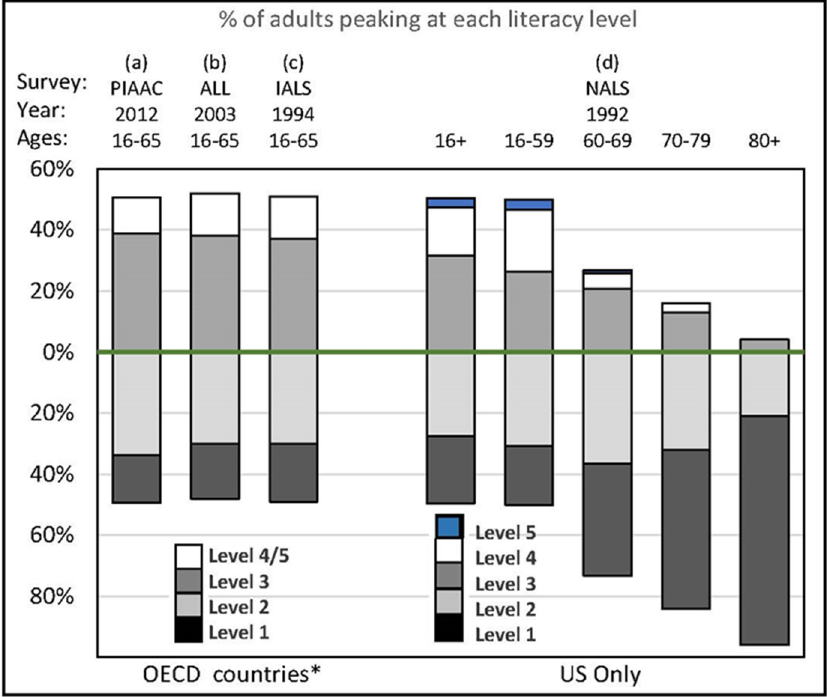
Figure 2. A nation’s distribution of adult functional literacy (information-processing capacity) is predictable. * N of countries in the OECD surveys, respectively = 20, 6, 8 (U.S. included in the PIAAC and IALS). PIAAC = Programme for the International Assessment of Adult Competencies, ALL = Adult Literacy and Life Skills Survey, IALS = International Adult Literacy Survey, NALS = National Assessment of Adult Literacy, OECD = Organisation for Economic Cooperation and Development. Sources for PIACC (OECD 2013, Table A2.1); ALL (OECD 2011) and IALS (OECD 2000) data from online database at https://piaacdataexplorer.oecd.org/ide/idepiaac (accessed on 6 December 2021); and NALS (Kirsch et al. [1993] 2002, Figure 1.1 for ages 16+ and Brown et al. 1996, Tables 1.2 and 1.3, for specific age groups).